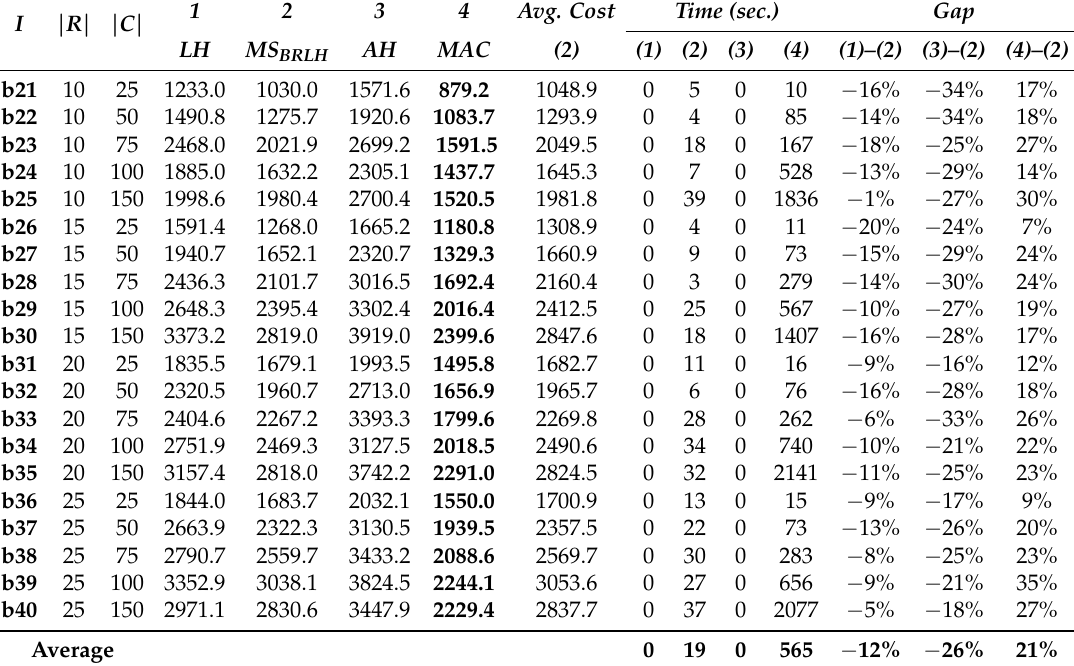
Table 4. Comparison of the results obtained by our methodologies (LH and MS BRLH ) with those obtained by Abdulkader et al. [1]’s methods (AH and MAC) in the relaxed inventory